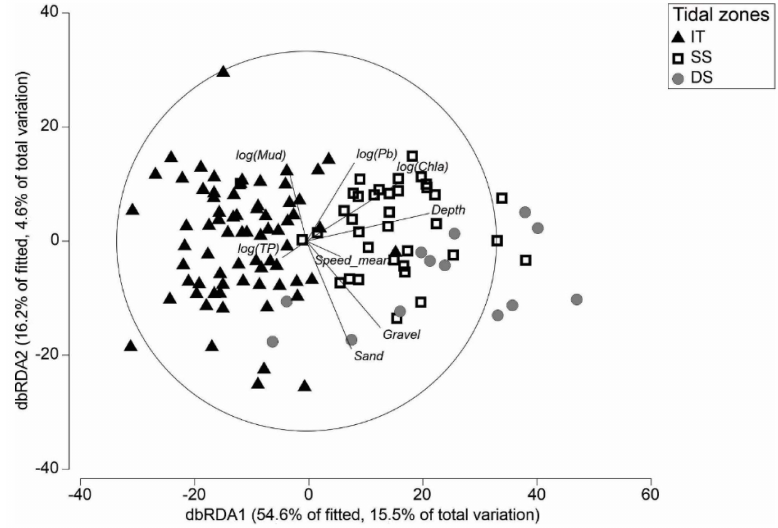
Figure 3. Distance-based redundancy analysis (dbRDA) plot visualizing the direction and influence of environmental predictors on shifts in macroinvertebrate community